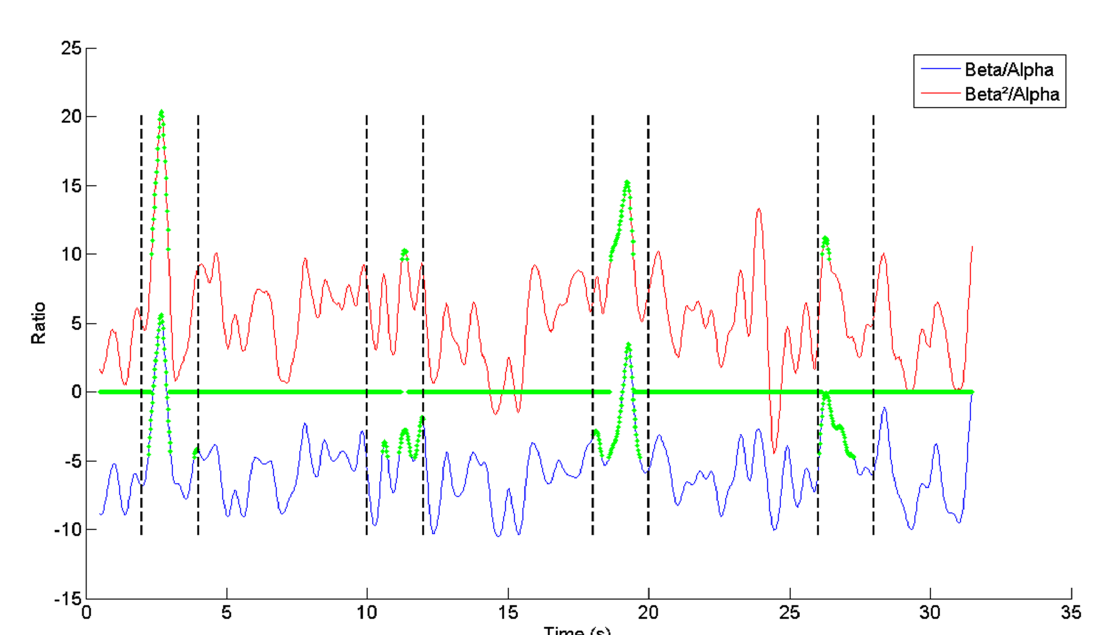
Figure 12. True positive values (green diamonds) for 4 events of desynchronization of the EEG (represented by vertical dotted lines). Blue trace: ratio beta/alpha; red trace: ratio beta²/alpha.